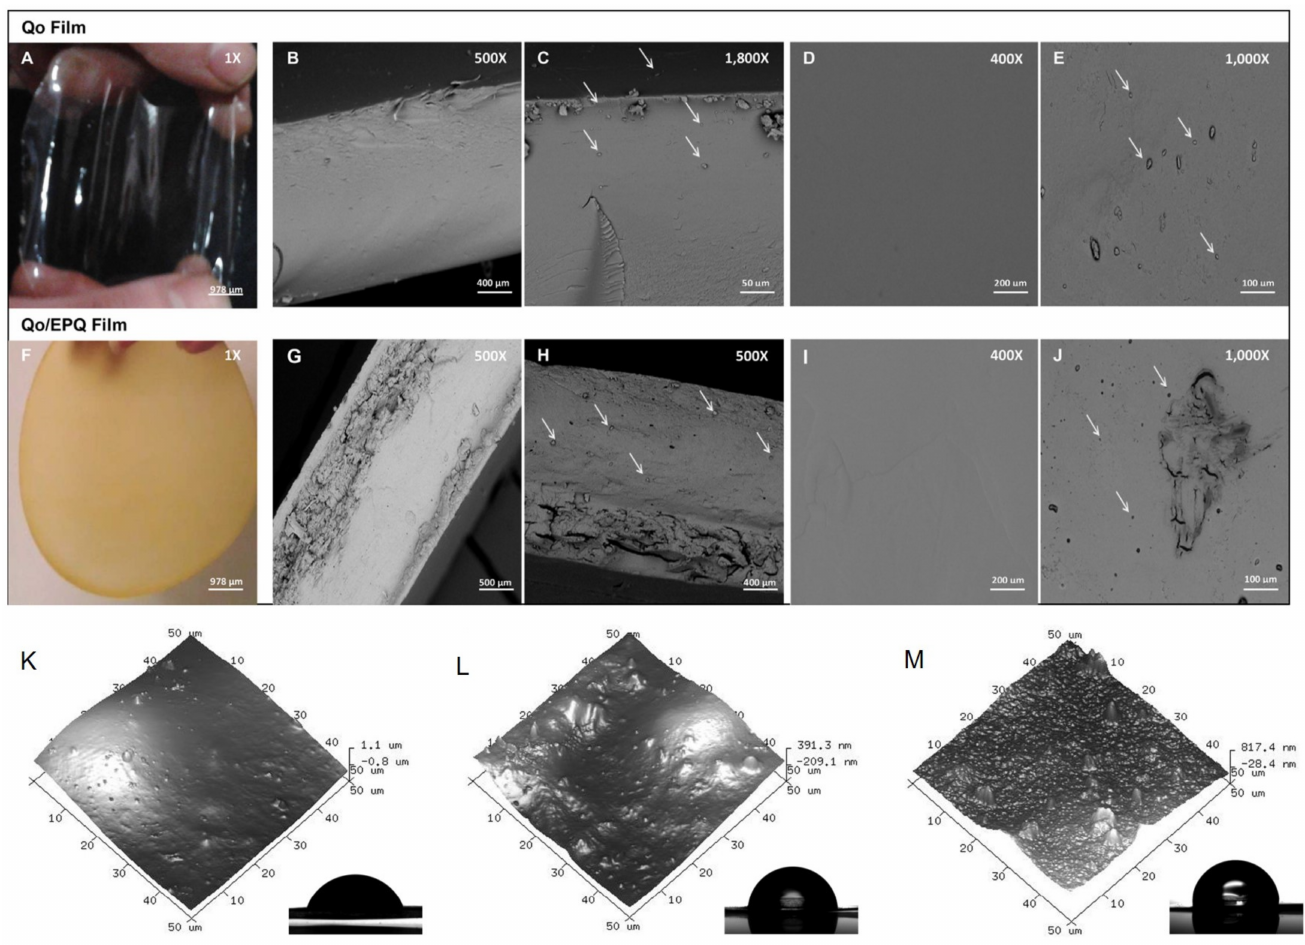
Figure 2. Camera pictures and the Scanning Electron Microscope pictures of NQoThs in Qo and Qo/EPQ films. ( A ) Camera picture of Qo film. ( B , C ) Cross-section of Qo film. ( D , E ) Surface of Qo film. ( F ) Camera picture of Qo/EPQ film. ( G , H ) Cross-section of Qo/EPQ film. ( I , J ) Surface of Qo/EPQ film. ( K ) Surface of Tara gum film. ( L ) Surface of Tara gum film incorporated with bulk CS. ( M ) Surface of Tara gum film incorporated with CS nanoparticles. Adapted from References [42,46], with permission from